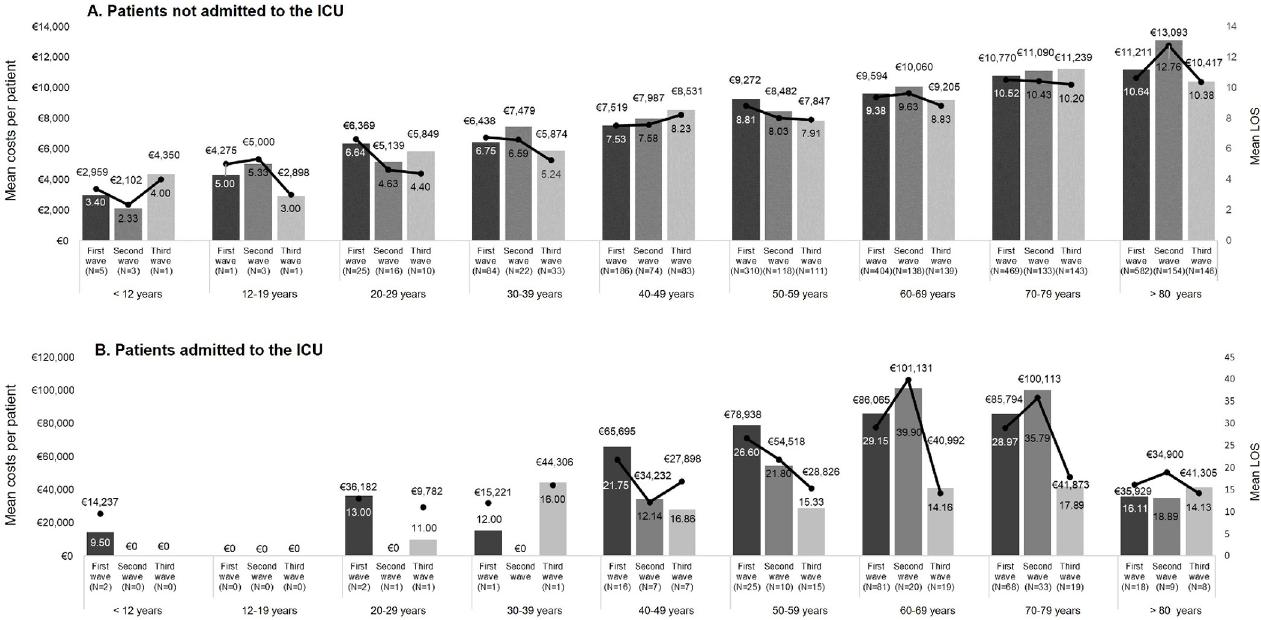
Fig 3. Mean costs and LOS per patient associated with COVID-19 hospitalization in the different outbreak waves stratified by the vaccination age bands for patients who were not (A) and who were (B) admitted to the ICU. Abbreviations: ICU (intensive care unit); LOS (length of stay). Costs are estimated as unadjusted means.